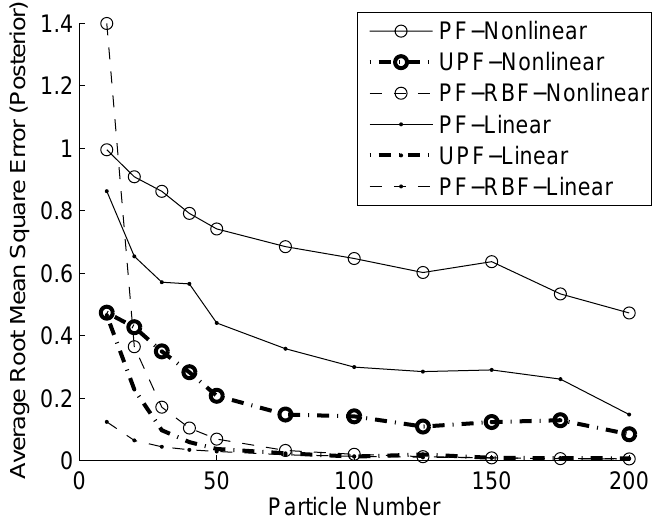
Figure 4. The average RMSEs of three algorithms calculated over 100 independent runs with the linear and non-linear observation